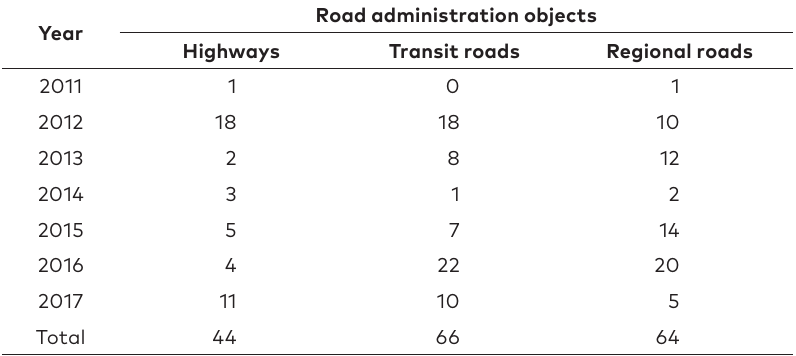
Table 3. Road Safety Audit count by different road administration